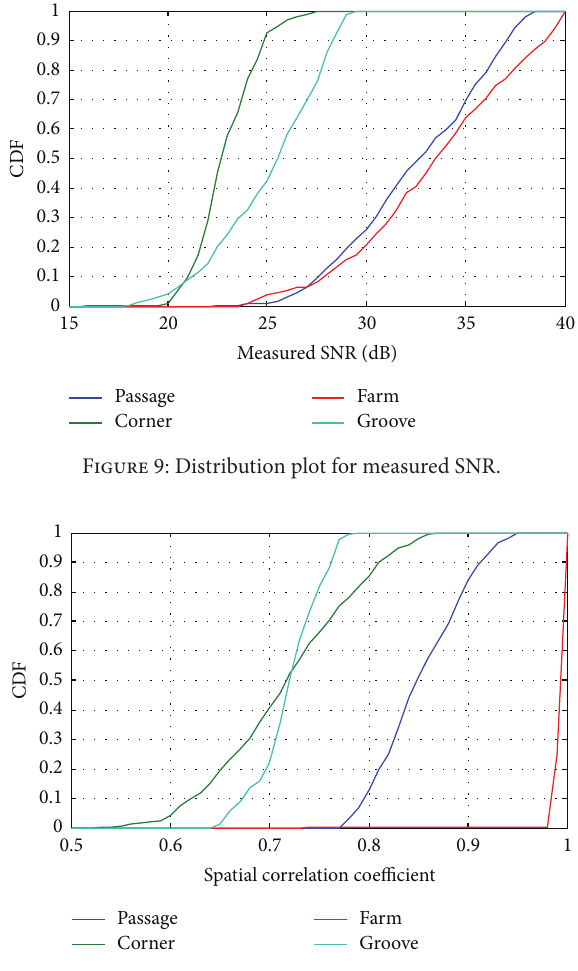
Figure 12: Distribution plot for measured channel